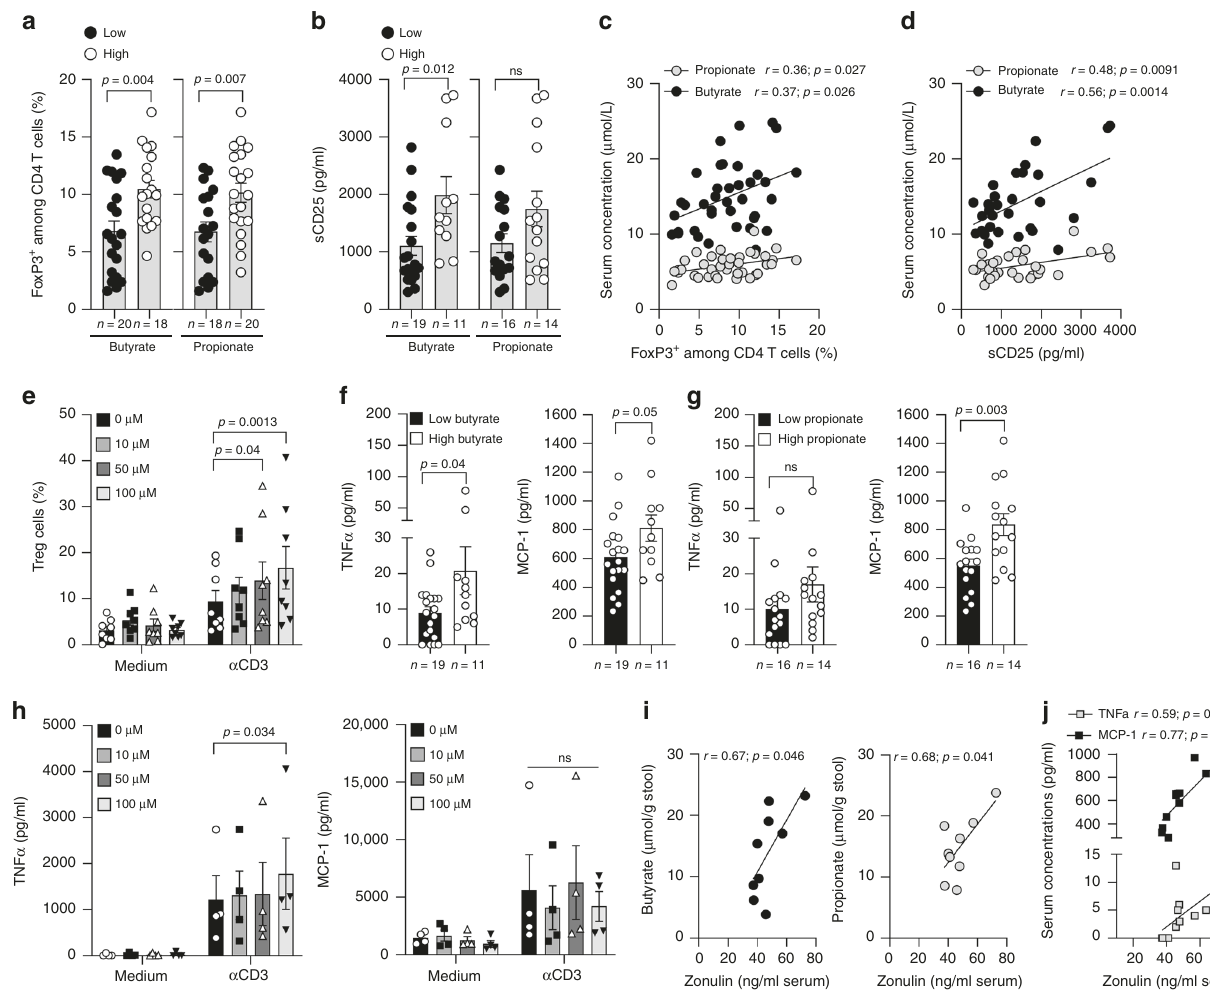
Fig. 5 Baseline immunological markers according to serum butyrate or propionate levels. a , b Mean (SEM) percentage of blood Treg (FoxP3 + among CD4 + T cells; a ) and mean (SEM) sCD25 ( b ) according to median concentration of serum butyrate (left panel) and propionate (right panel) concentrations before ipilimumab treatment (V1). c , d Pearson correlations between butyrate and propionate quanti fi cation in serum and percentages of peripheral Treg ( c ; n = 38) and sCD25 ( d ; n = 30) before ipilimumab treatment (V1). e Mean (SEM) percentage of Treg in human PBMC ( n = 8) after 4 days of culture with or without anti-CD3 and escalating concentrations of butyrate. f Mean (SEM) concentrations of systemic TNFa (left panel) and MCP-1 (right panel) according to median concentration of serum butyrate. g Mean (SEM) of systemic TNFa (left panel) and MCP-1 (right panel) according to median concentration of serum propionate. h Mean (SEM) TNFa (left panel) and MCP-1 (right panel) secretions by human PBMC ( n = 4) stimulated during 4 days with or without anti-CD3 and escalating concentrations of butyrate. i Spearman correlation between butyrate (left panel) and propionate (right panel) quanti fi cations in the stool and zonulin in the serum from patients ( n = 9, where both data were available) before ipilimumab treatment (V1). j Spearman correlation between zonulin and serum concentrations of TNFa (light gray squares) and MCP-1 (black squares) ( n = 12, where both data were available). Each dot represents one patient; n (number of patients) are indicated on each graph otherwise stated in the legend. P -values are indicated on each graph; Two-tailed unpaired t test ( a , b , f , g ) and two-way RM ANOVA followed by Tukey ’ s tests for multiple comparisons was used ( e and h ). ns, not signi fi